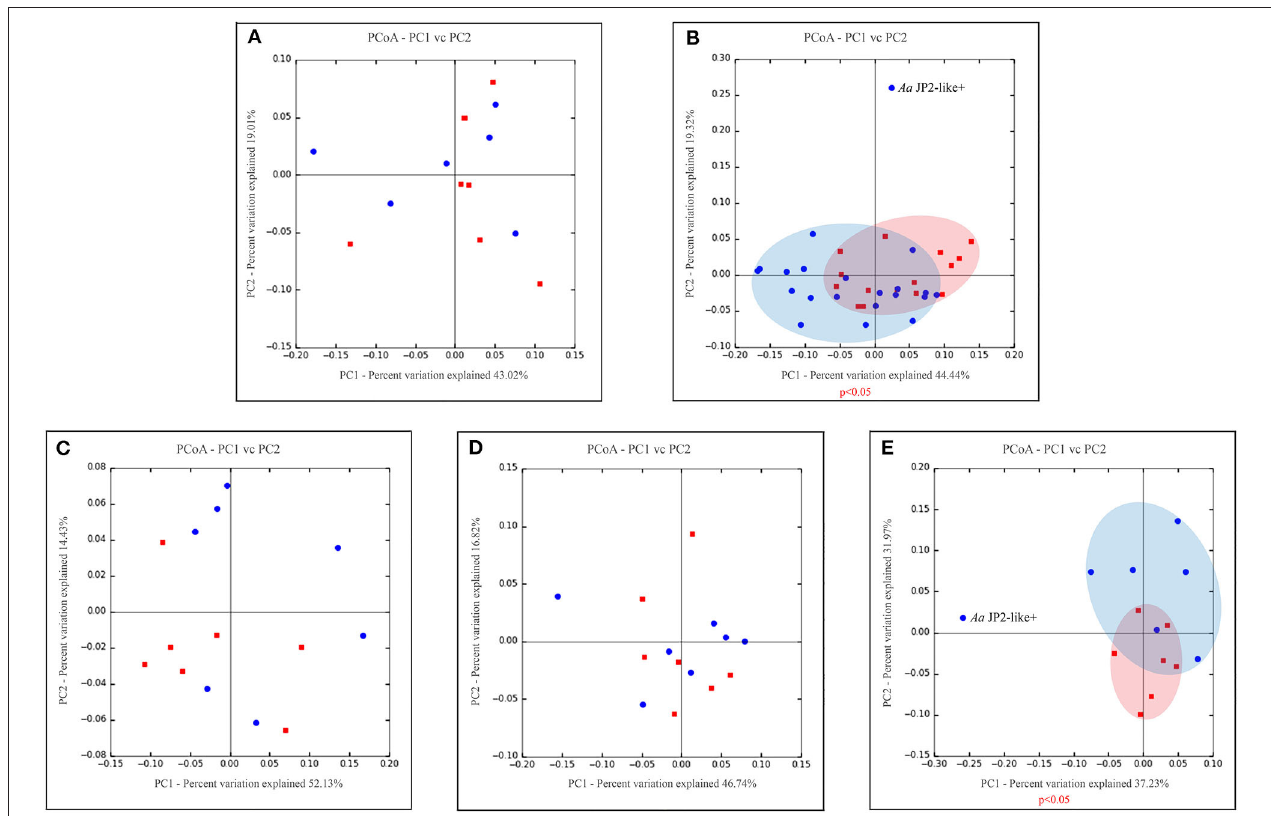
FIGURE 4 | Principal coordinate analysis based on weighted UniFrac distance metric. Graphics represents beta diversity analysis between samples: fecal (A) , oral (supra + subgingival sites sampled) (B) , supragingival sites (C) , subgingival non-affected sites of GC/MIP and Control and (D) , subgingival affected sites of GC/MIP and subgingival sites of Control (E) . Blue dots correspond to GC/MIP samples and red dots correspond to Control samples. Blue or light red ellipses indicate groups of samples closely related. A significance level of 5% was applied by using PERMANOVA test (vegan::adonis). Only one GC/MIP case harbored the Aa JP2-like + clone, which clustered apart from the other GC/MIP samples, as signalized in (B,E)